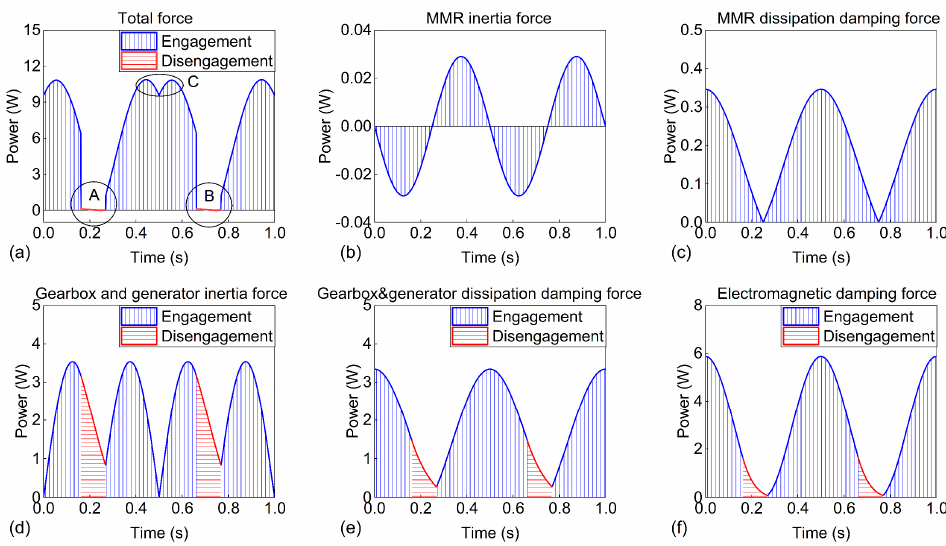
Figure 10. Different force powers (parameters of input: A = 20 mm, f = 1.0 Hz, R load = 20 Ω ). ( a ) Total force power. ( b ) MMR inertia force power. ( c ) MMR dissipation damping force power. ( d ) Gearbox and generator inertia force power. ( e ) Gearbox and generator dissipation damping force power. ( f ) Damping force power.